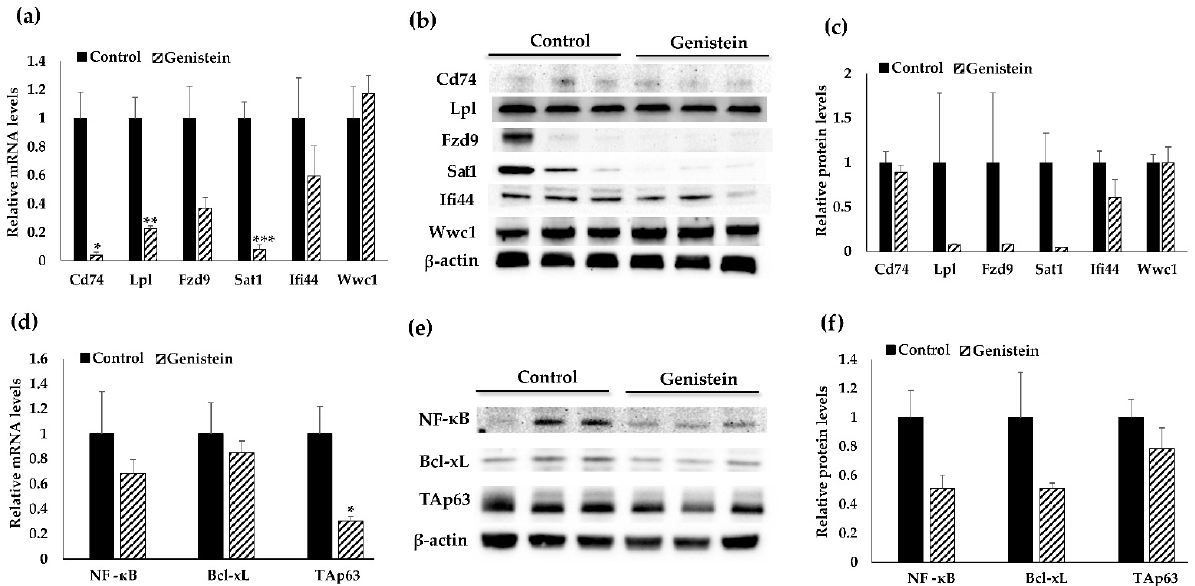
Figure 4. Validation analyses of 6 candidate genes expression and Cd74-regulated signal pathway. Real-time PCR and Western blot analysis were performed in triplicates to evaluate gene expression changes of Cd74, Lpl, Fzd9, Sat1, Ifi44, Wwc1, NF- κ B, TAp63 and Bcl-xL in TNBC PDX tumors of BCM-32045 from both control and GE treatment groups ( n = 3/patient/group). ( a ) Relative gene expression in transcriptional level in 6 identified target genes. ( b ) Protein expression of 6 identified target genes, ( c ) Quantification of the target protein levels. ( d – f ) Cd74-regulated signal pathway genes including NF- κ B, Bcl-xL and TAp63 in transcriptional ( d ) or protein ( e ) levels as well as protein quantification of these genes ( f ). The transcription or protein expression levels were normalized to the relevant housekeeping control and calibrated to control group. Representative blots were selected from experiments that were repeated three times. Columns, mean; bars, SE; * p < 0.05, ** p < 0.01, *** p < 0.001 significantly different from the control group.